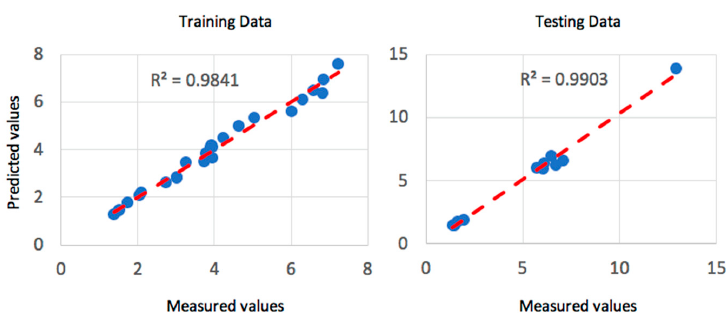
Figure 11. Coefficient of determination R 2 for the training and testing dataset of the cryogenic turning process.